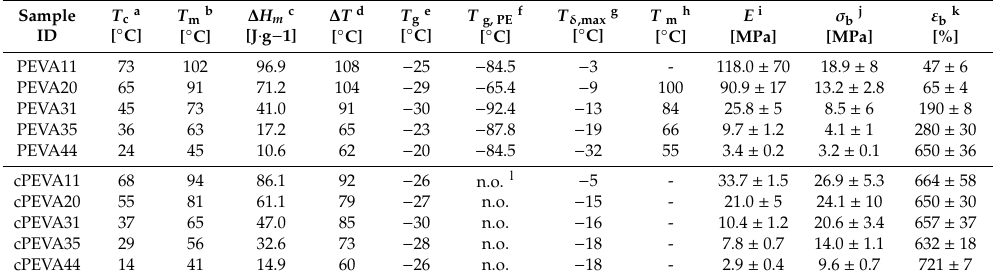
Table 2. Thermal and mechanical properties of PEVA and